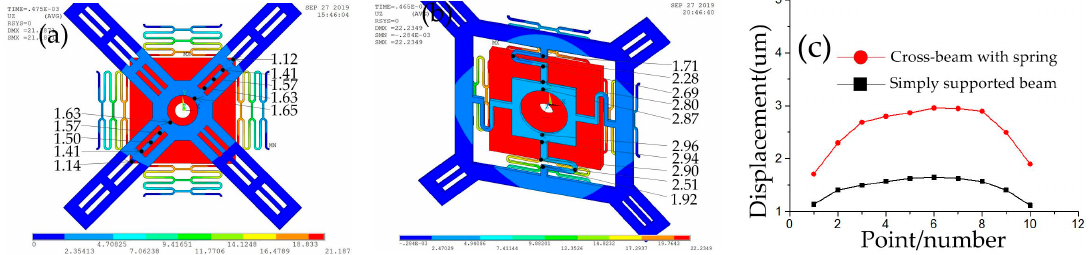
Figure 9. ( a ) Maximum displacement of model 3 with 600 g acceleration. ( b ) Maximum displacement of model 5 with 600 g acceleration. ( c ) Vibration tracks of fixed electrodes.